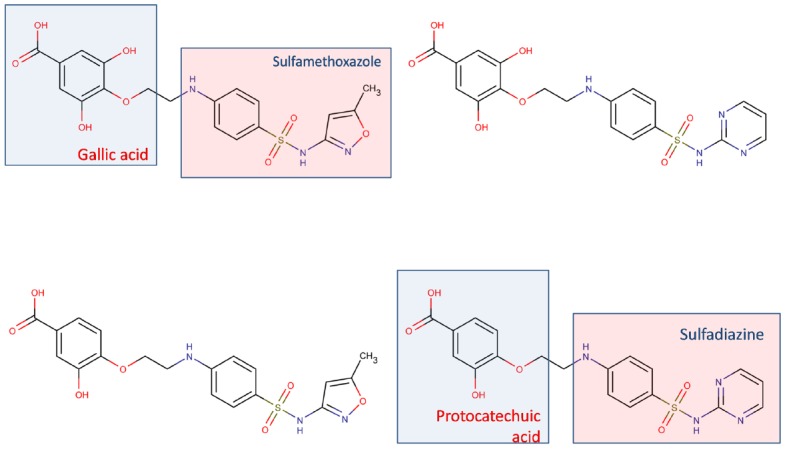
Multi-target antibiotic phyto-drug conjugates designed by Jayaraman et al. (2013).